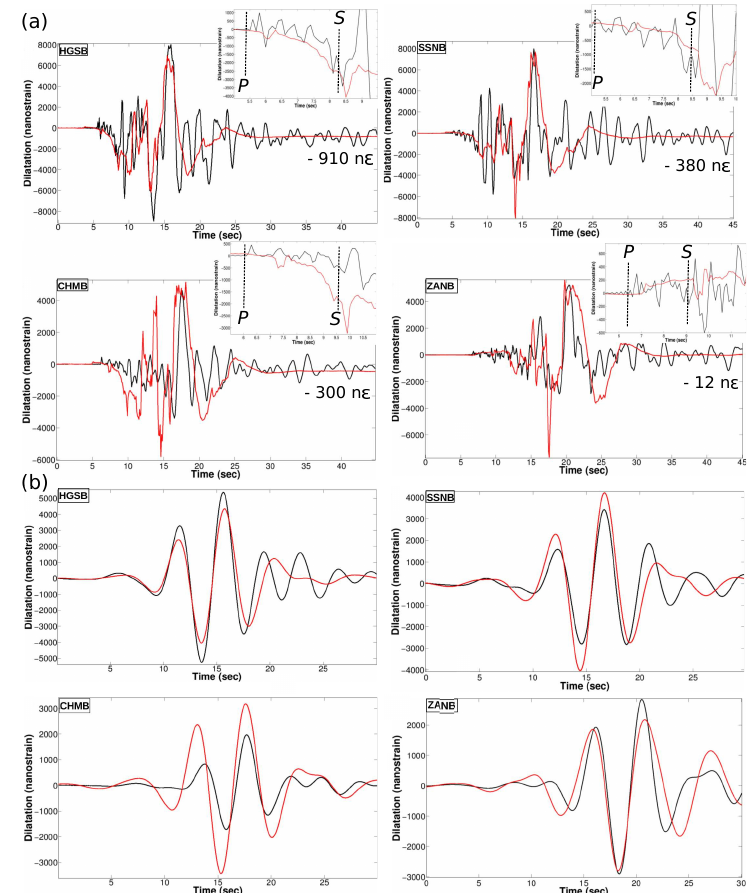
Figure 8. ( a ) High-sampling rate (100 Hz) dilatation signals recorded by stations located in the Ruisui network during the 2013 M w 6.2 Ruisui earthquake (black curve) and simulated time-series using the discrete wavenumber representation method and a simple rupture model (5 point sources) (red curve). Top inset is a zoom on the near- and intermediate field initiating between P and S wave arrivals (vertical dashed lines). Expansion is positive. ( b ) Recorded dilatation signals (black curve) and modeled signals (red curve) filtered between 3 to 7 s. Modified from [34] with permission from Springer